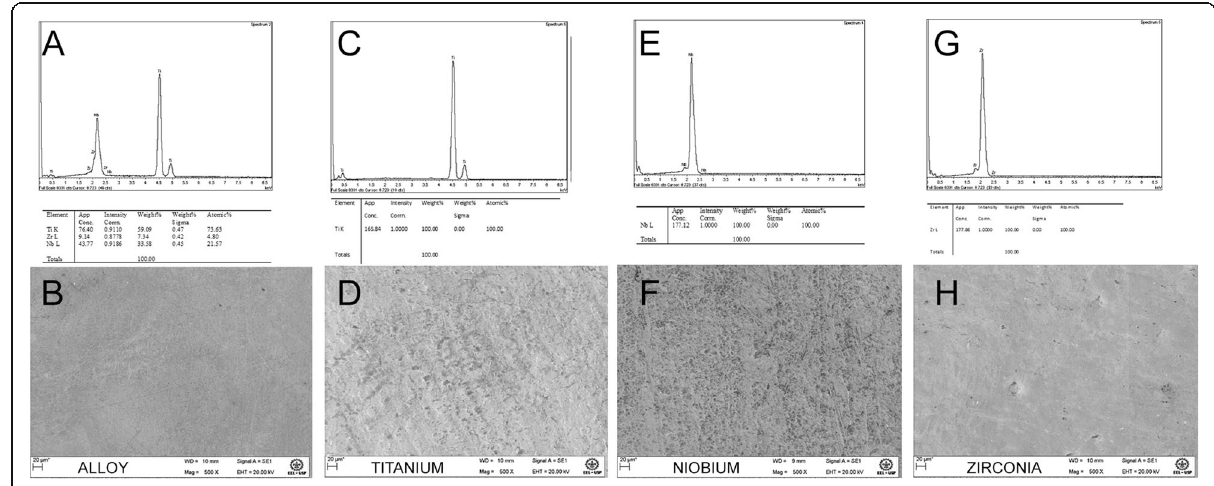
Fig. 1 Energy-dispersive X-ray spectroscopy (EDS) showed the composition of the samples in percentage. a Titanium alloy — TiNbZr. c Pure titanium — Ti(cp). e Niobium — Nb. g Zirconia — Zr. Scanning electron micrograph images of the samples showed the differences of the surfaces. b Titanium alloy — TiNbZr. d Pure titanium — Ti(cp). f Niobium — Nb. h Zirconia —